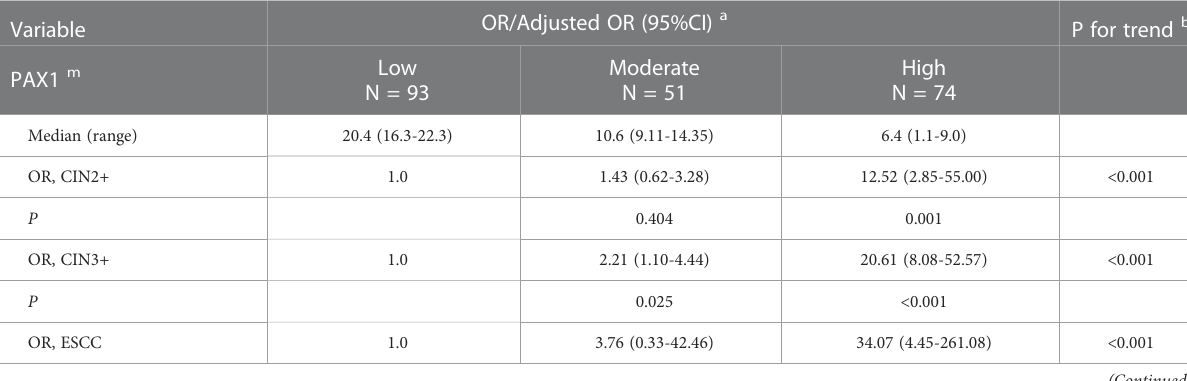
TABLE 2 PAX1 m levels strati fi ed by low-, medium-, and high-risks of CIN2+, CIN3+ and ESCC.